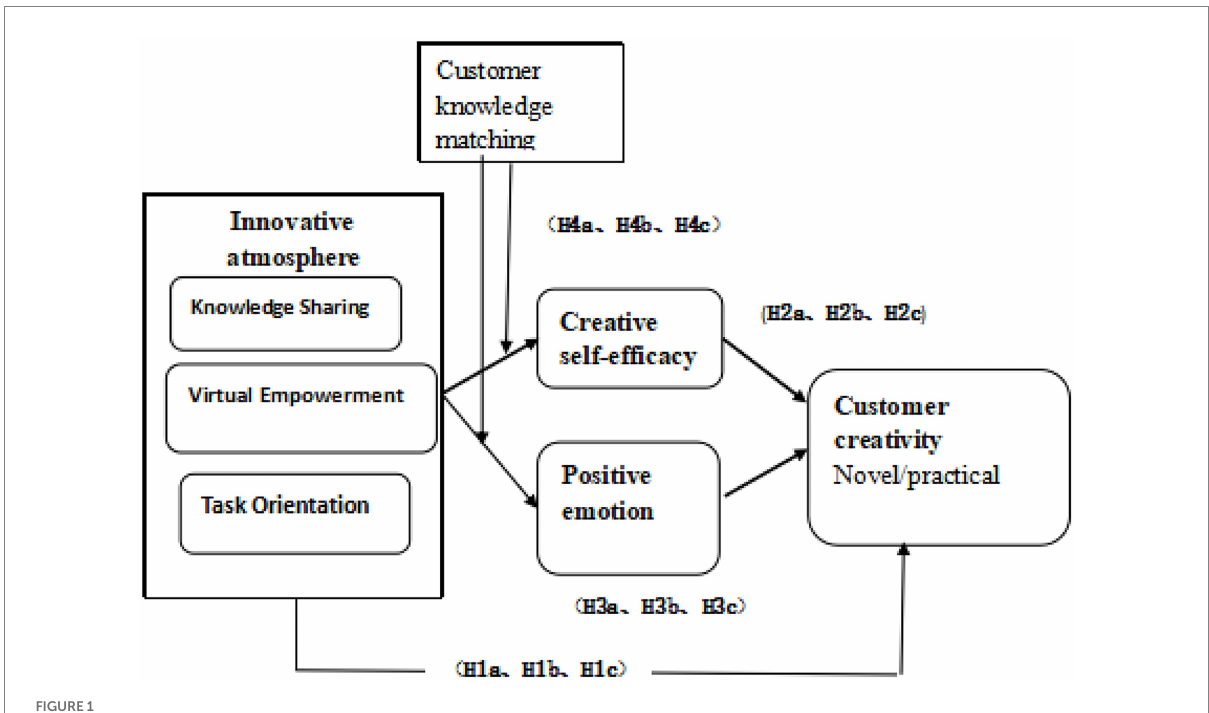
FIGURE 1 Theoretical